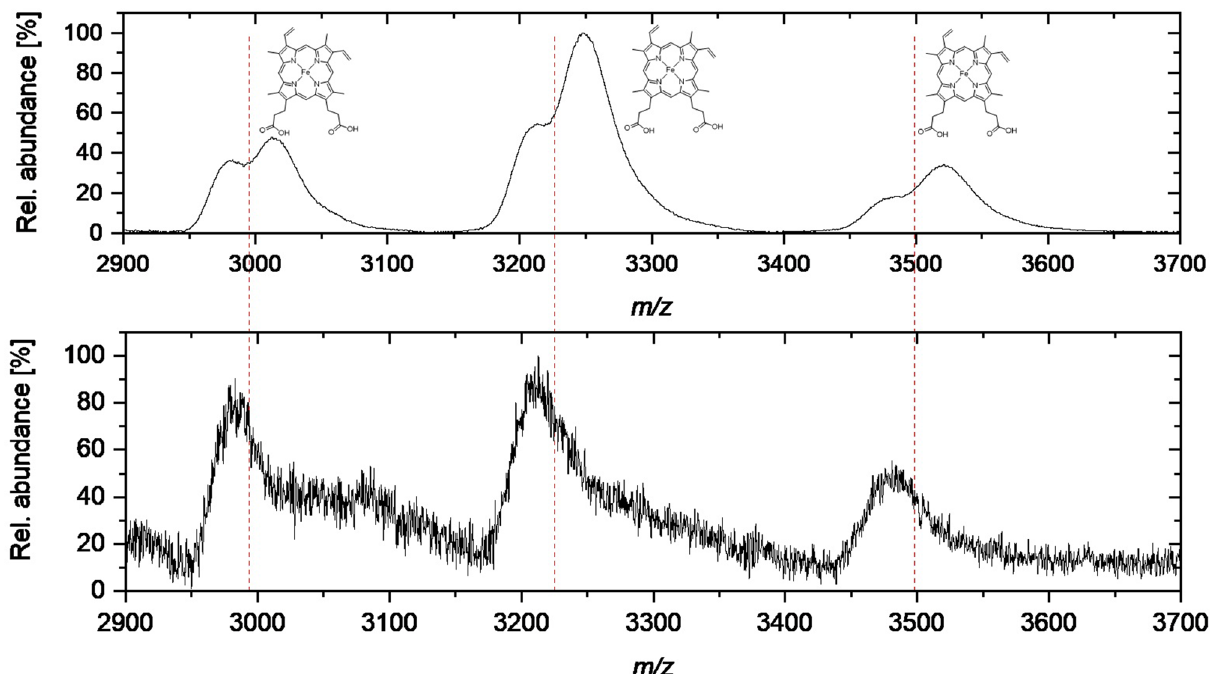
Figure 4. Overlay of excerpts of native (upper) and denaturated (lower) wild-type oxdb mass spectra. The shown region refers to 2930 and 3520 m/ z , in which the peaks refering to the charge states + 11 to + 13 are